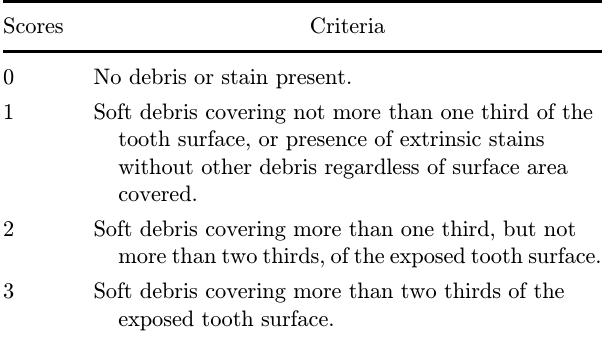
Table 1. Criteria for classifying